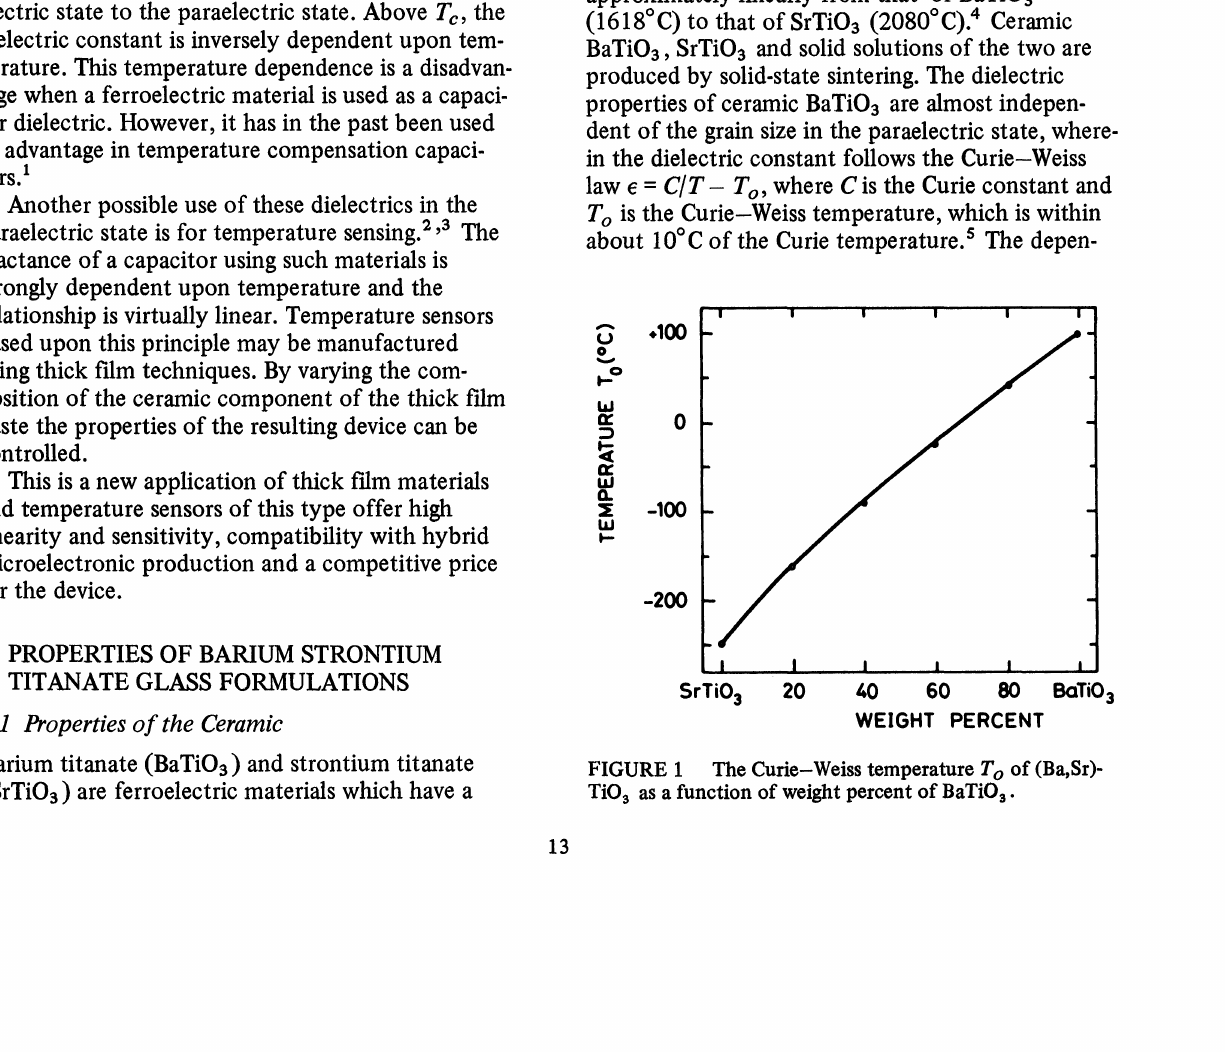
The Curie-Weiss temperature T O of (Ba, Sr)- TiO as a function of weight percent of BaTiO.